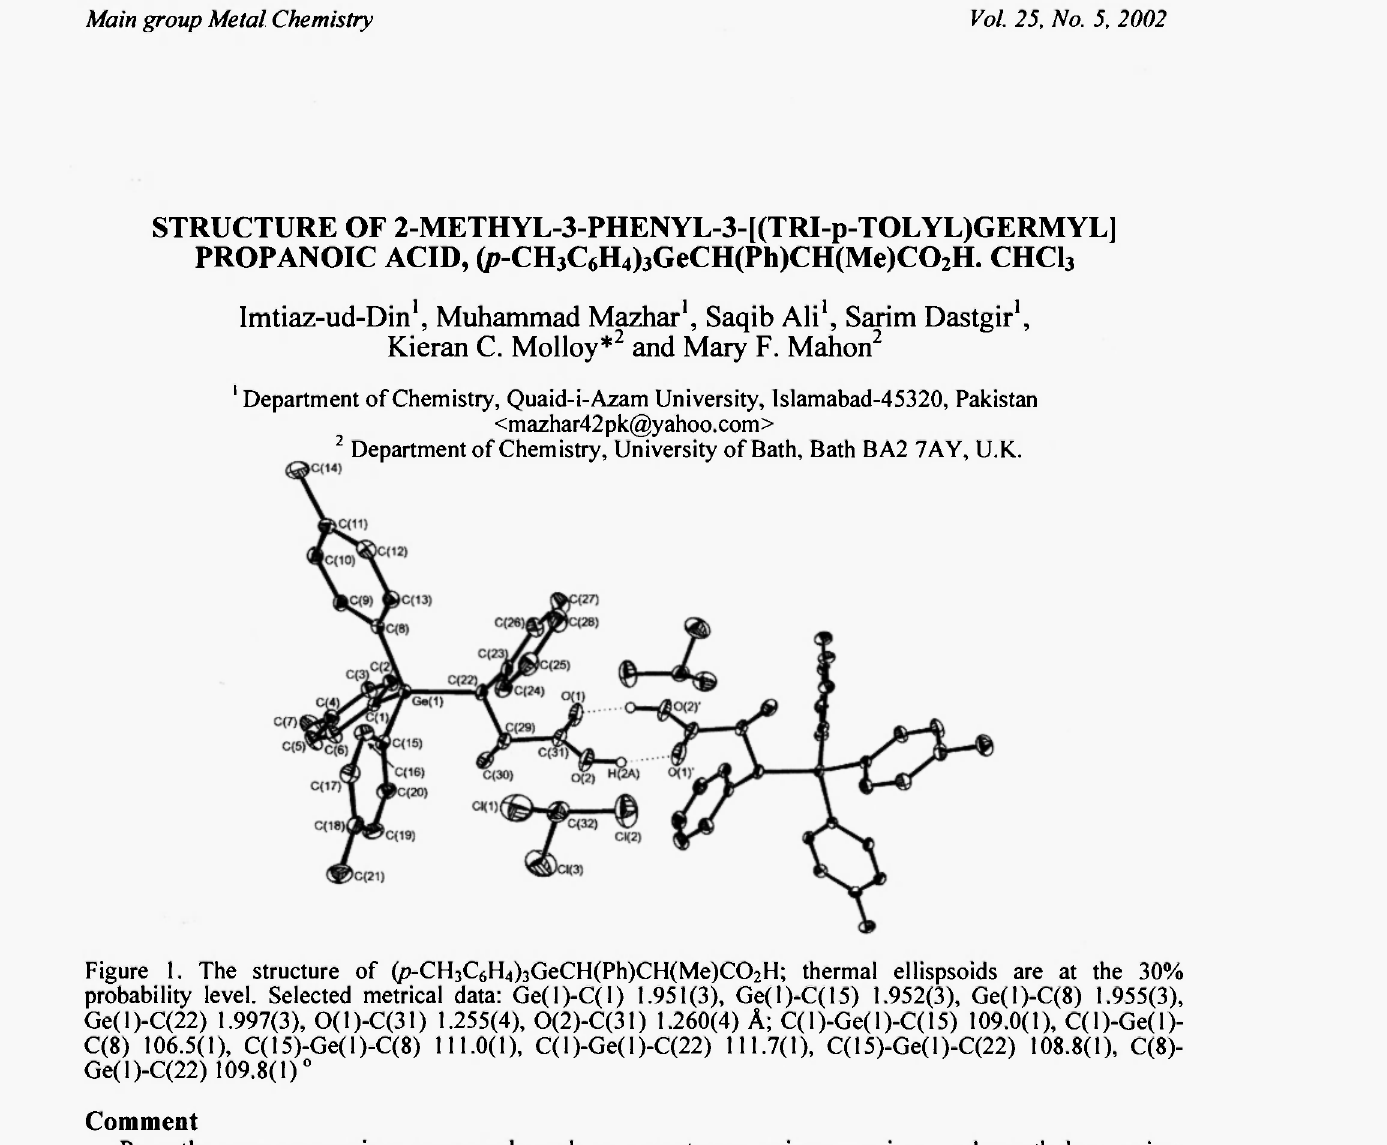
Figure 1. The structure of (/)-CH 3 C 6 H 4 )3GeCH(Ph)CH(Me)C0 2 H; thermal ellispsoids are at the 30% probability level. Selected metrical data: Ge(l)-C(l) 1.951(3), Ge(l)-C(15) 1.952(3), Ge(l)-C(8) 1.955(3), Ge(l)-C(22) 1.997(3), 0(1)-C(31) 1.255(4), 0(2)-C(31) 1.260(4) A; C(l)-Ge(l)-C(15) 109.0(1), C(l)-Ge(l)- C(8) 106.5(1), C(15)-Ge(l)-C(8) 111.0(1), C(l)-Ge(l)-C(22) 111.7(1), C(15)-Ge(l)-C(22) 108.8(1), C(8)- Ge(l)-C(22)